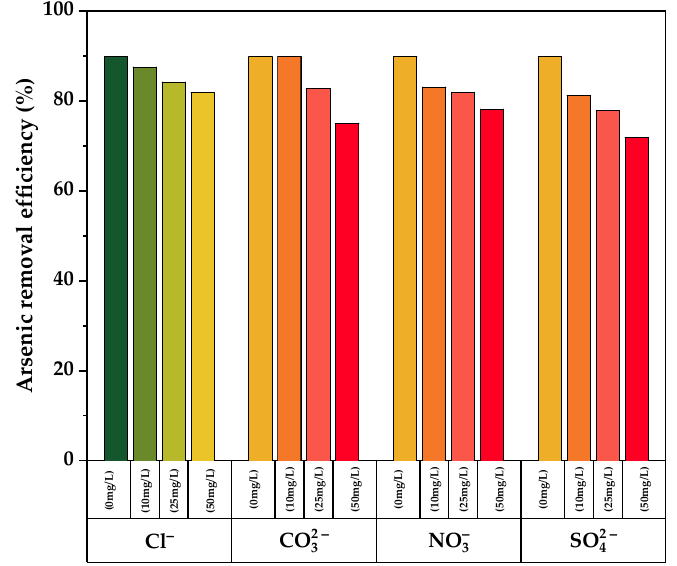
Figure 9. Effect of various competing ions on Arsenic removal by pure and doped TiO 2 -B.